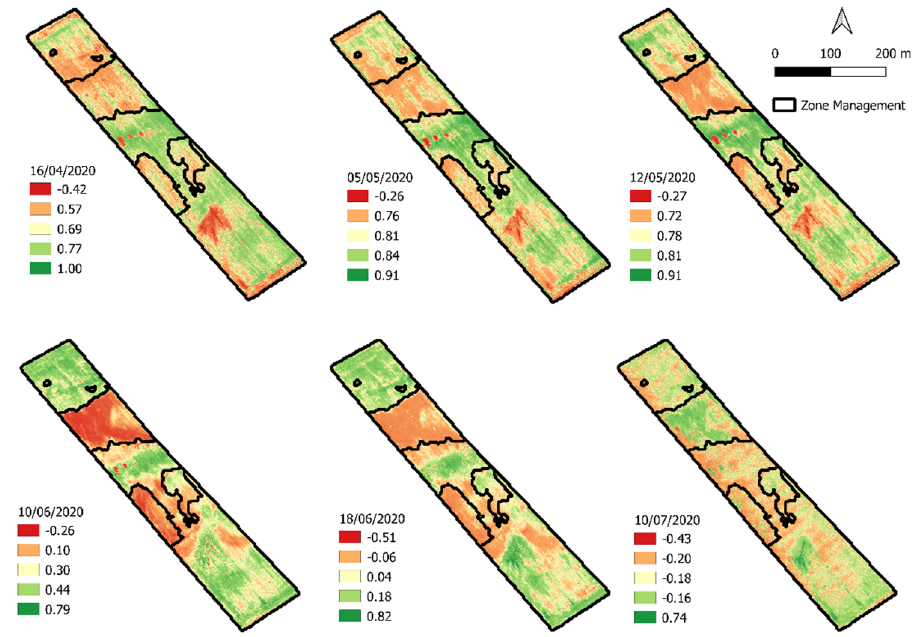
Figure 5. The NDVI maps reported for all growing seasons at site 1.